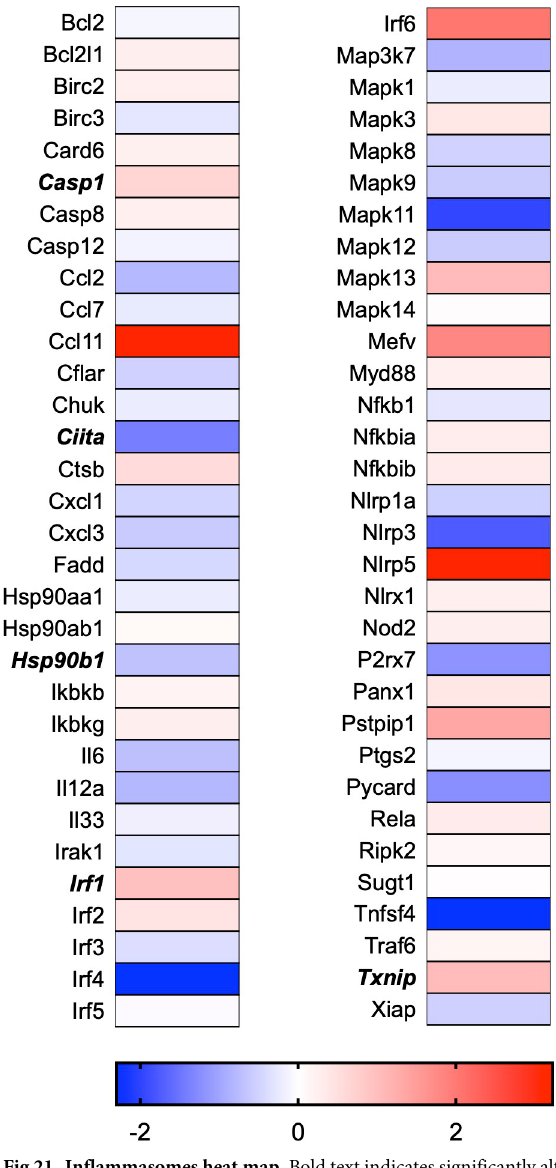
Fig 21. Inflammasomes heat map. Bold text indicates significantly altered gene